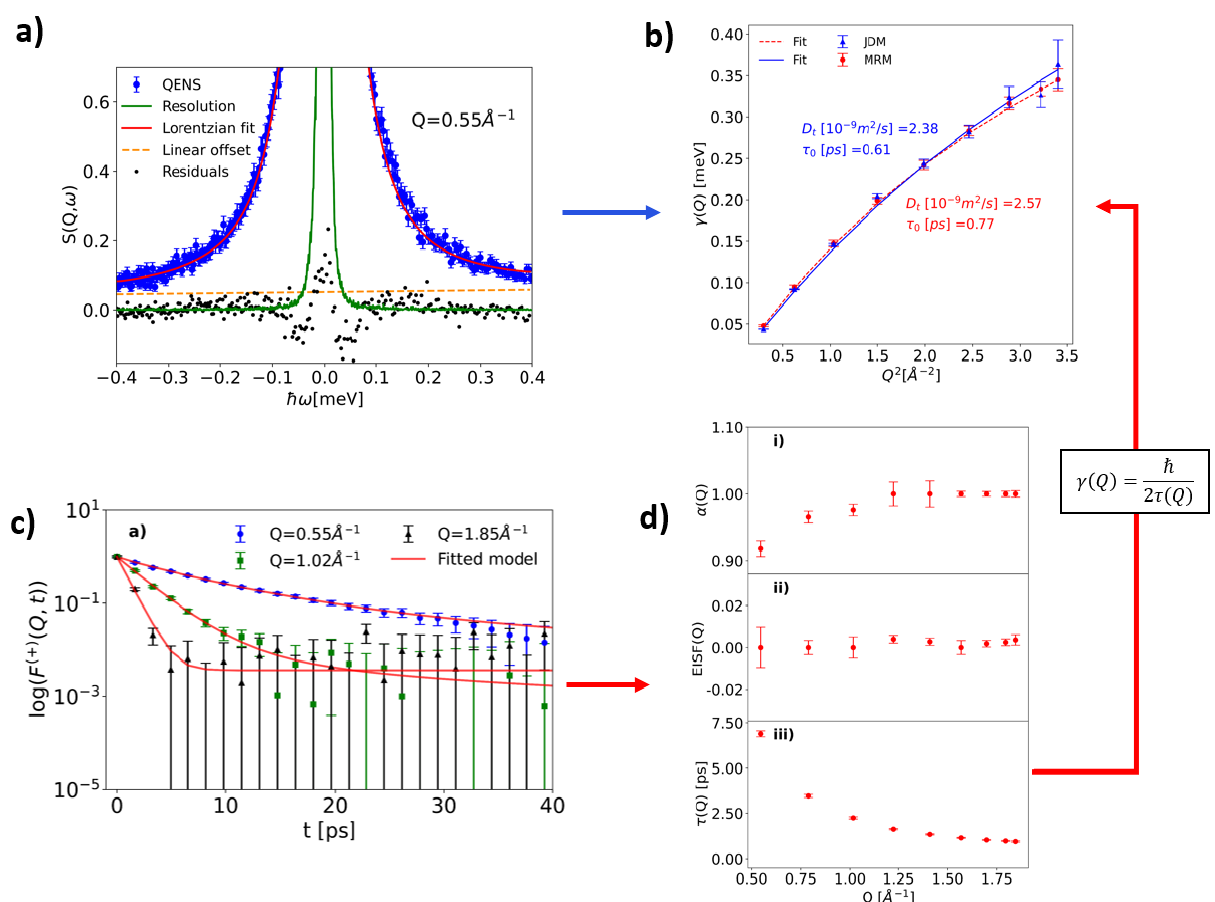
Figure 2. Overview of the data analysis performed on the QENS spectra for bulk-water at 300 K . a) The jump di ff usion model (JDM) fit of the dynamic structure factor, S ( Q ,ω ), according to Eq. 10. The residuals between the Lorentzian fit and the QENS spectrum are also plotted along with the resolution and the linear background. b) The half width at half maximum (HWHM) γ ( Q ) JDM values extracted from each JDM fit as a function of Q 2 , compared to the HWHM γ ( Q ) MRM determined from the τ ( Q ) parameter of the multi- scale relaxation model (MRM). Both sets of HWHM data are fitted using, Eq. 12, where the fit results are presented above / below the fit in a corresponding color. c) MRM fit of the symmetrized, normalized, and deconvolved intermediate scattering function, F ( + ) ( Q , t ), according to Eq. 8. d) Water dynamics parameters of the QENS spectra as a function of Q obtained from the MRM model fit of F ( + ) ( Q , t ): i) α ( Q ), ii) the EIS F ( Q ), and iii) τ ( Q ). The lack of Q-dependence and zero value for the EIS F ( Q ) reflects that, as expected, the water molecules are not spatially